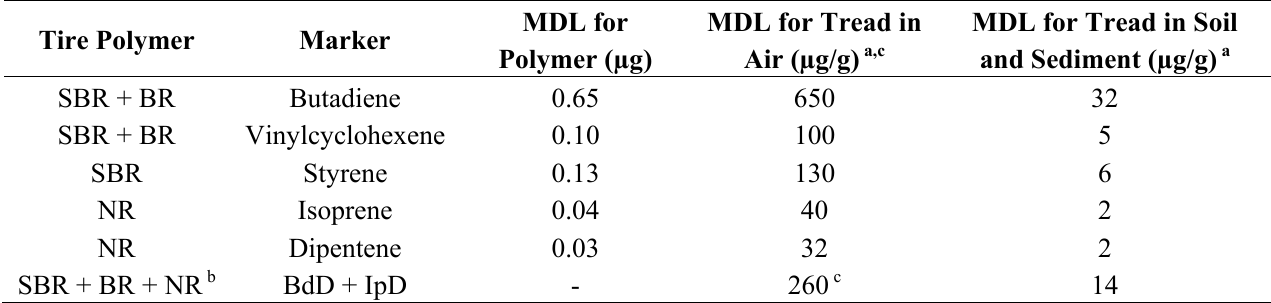
Table 4. Method detection limit (MDL) for polymer and tread particulate. Tire